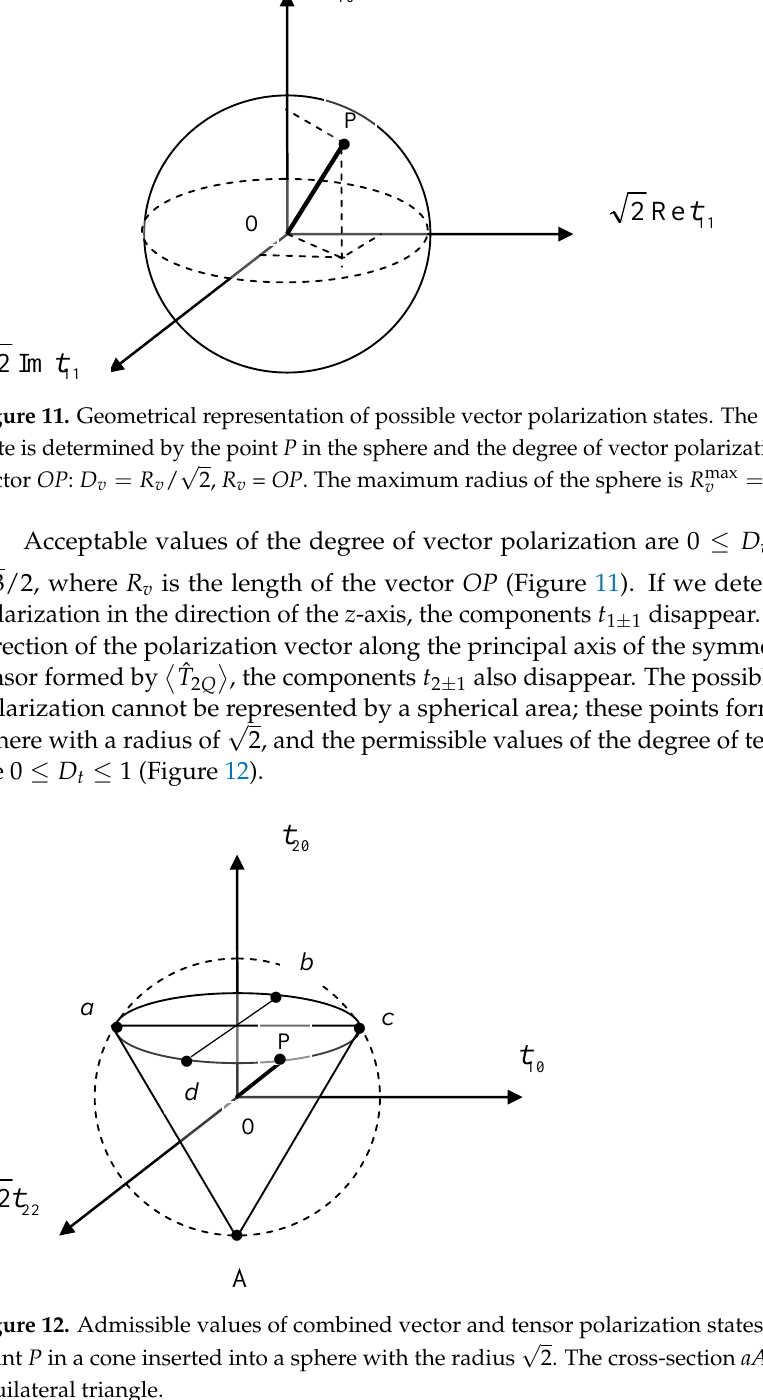
√ 2. The cross-section aAc of the cone is the